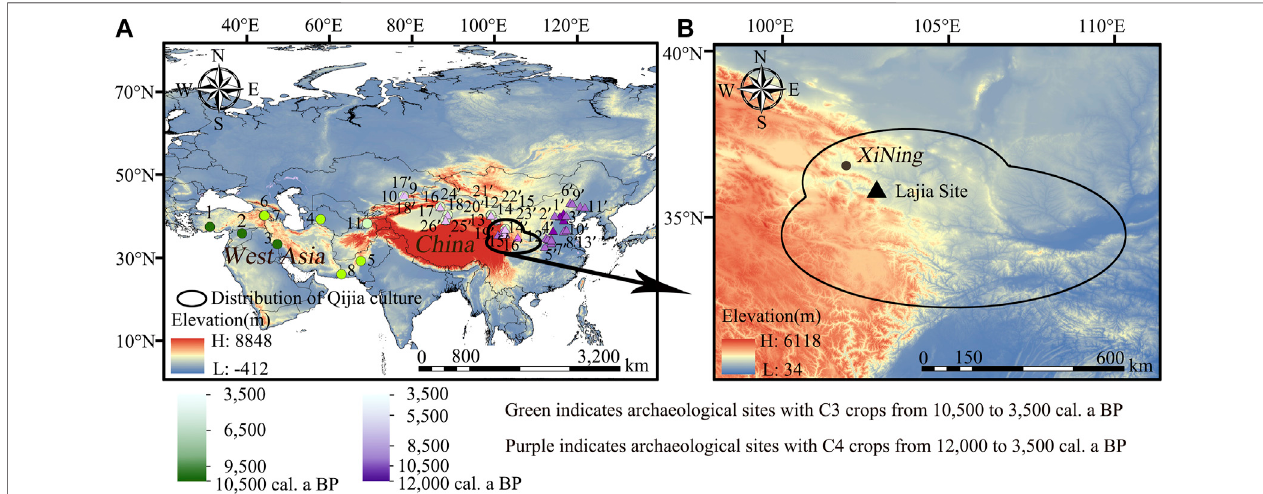
FIGURE1|(A) LocationofarchaeologicalsiteswithC3andC4cropsfrom12,000to3,500 calaBP(Modi fi edfromDongetal.,2017), (B) LocationoftheLajiasite.